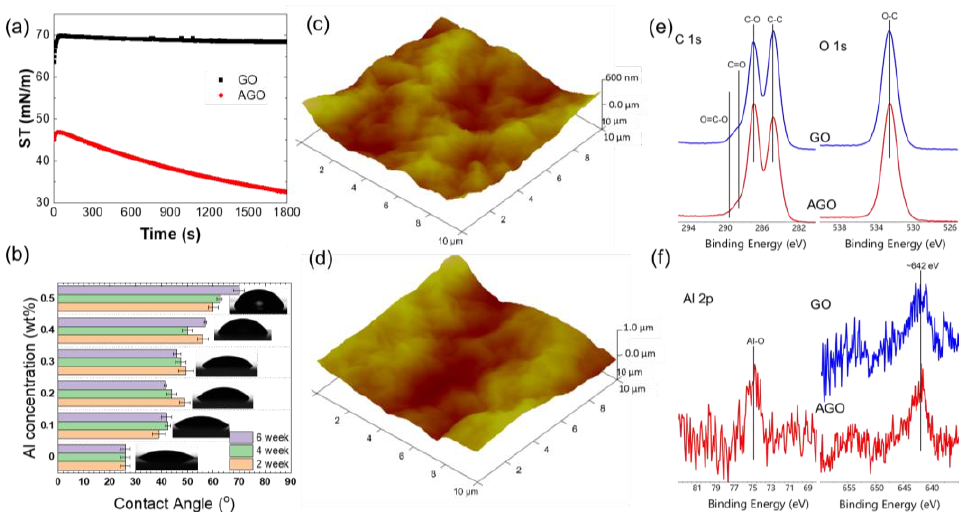
Figure 2. Effect of Al 3+ modification on GO and AGO sheet solutions and membranes formed via the layer-by-layer self-assembly method. The influence of Al 3+ on the ( a ) air–water interfacial surface tension of a GO sheet solution, ( b ) contact angle of GO membranes assembled on glass slides; AFM image of ( c ) pristine GO (height scale bar 600 nm) and ( d ) AGO (height scale bar 1 µm) membranes on thermal silicon oxide wafers; XPS spectra of ( e ) C 1s and ( f ) O 1s spectra of GO and AGO membranes.